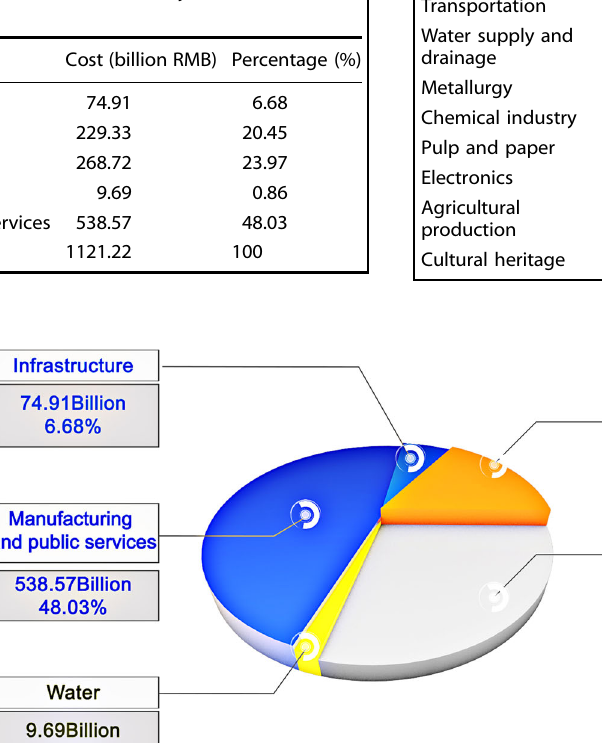
Table 8. The direct costs of corrosion of fi ve major economic sectors